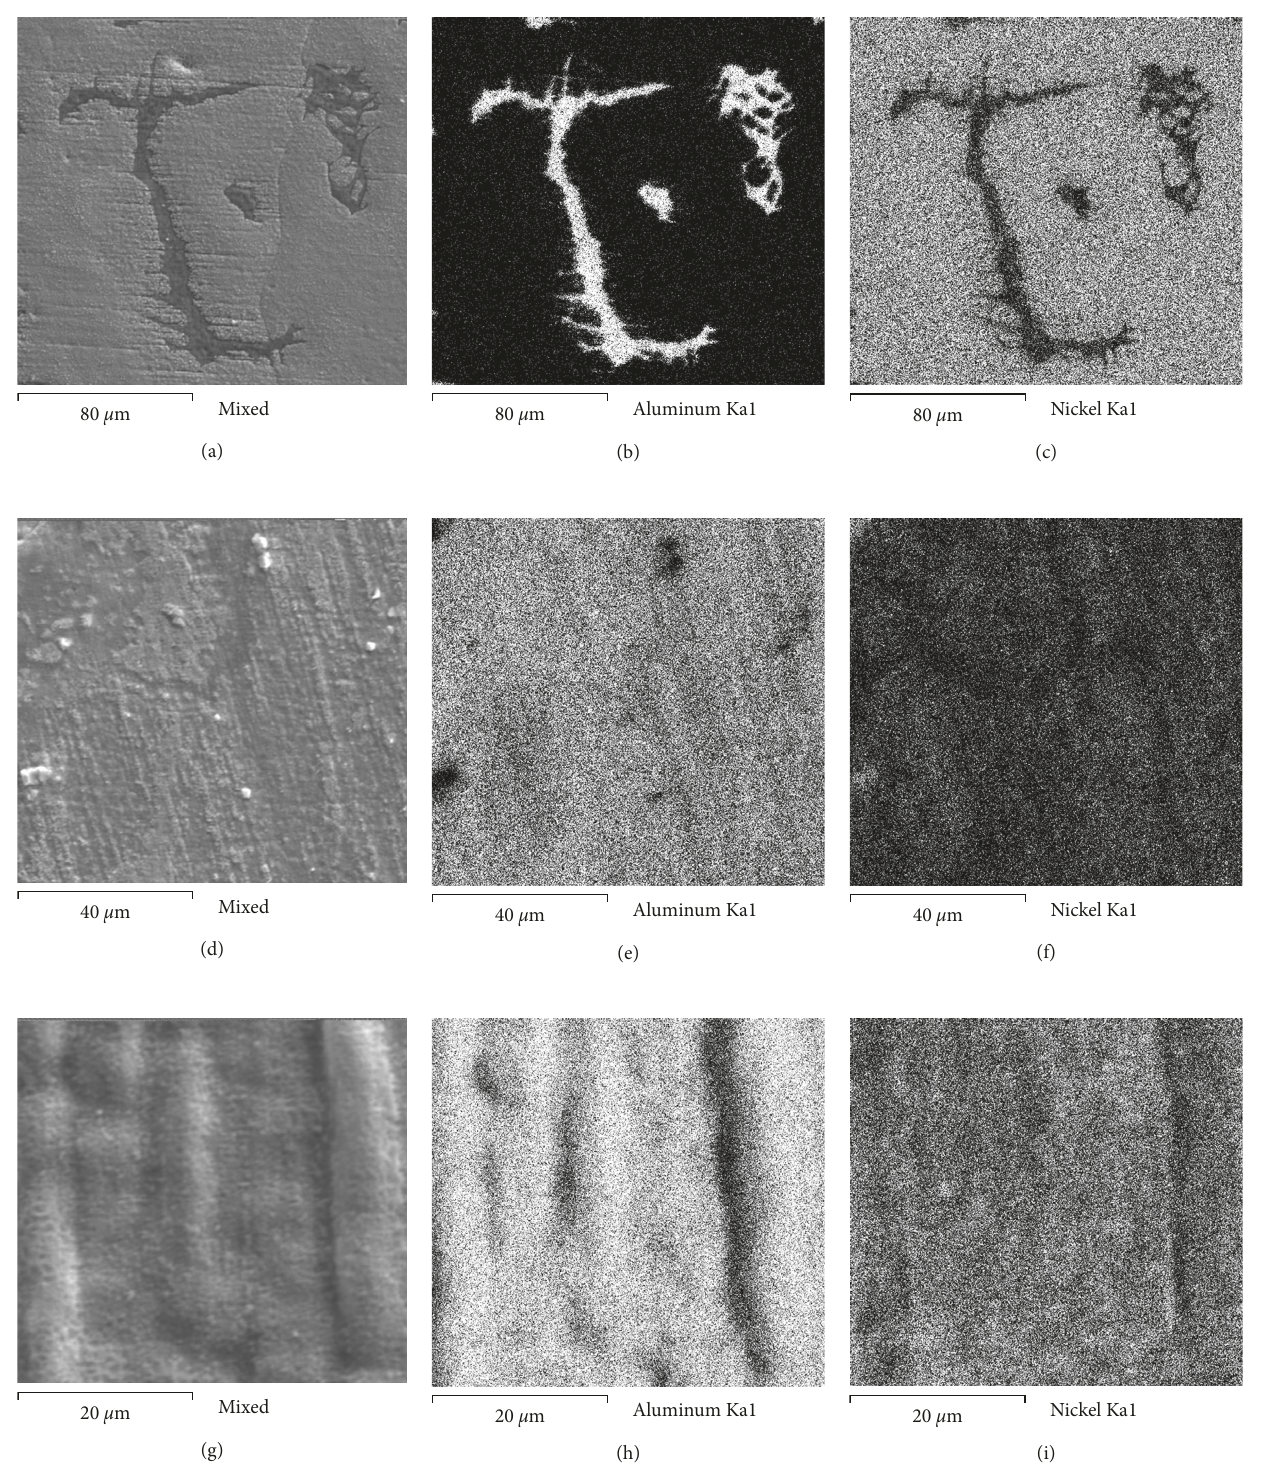
Figure 14: Superficial aspect and mapping elements of the oxide scale formed onto Ni